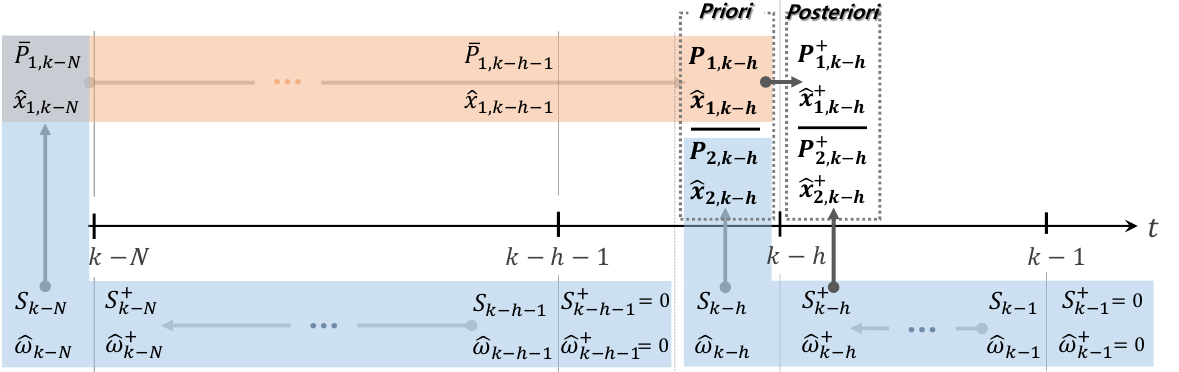
Figure 1. Concept and timing diagram of the RUMVRHF smoother. Algorithm 1 Recursion of UMVRHF smoother on the horizon [ k − N k − 1 ] . Sub-horizon [ k − N k − h − 1 ]